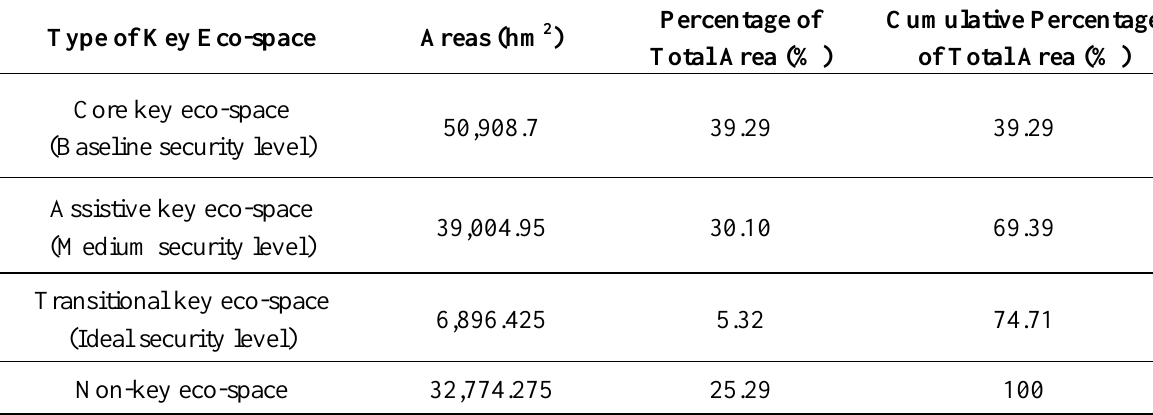
Table 6. Key eco-space types in Lanzhou